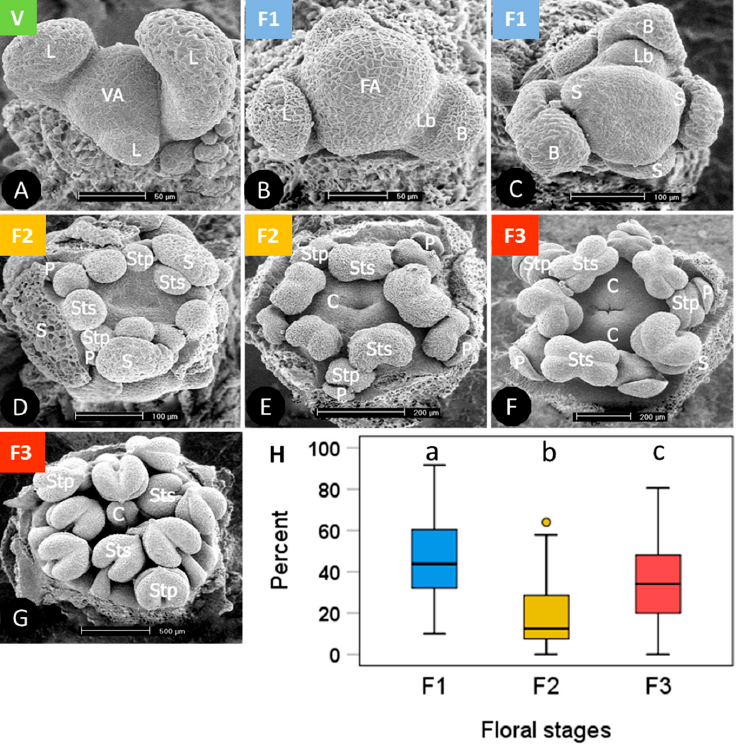
Figure 1. Saxifraga moschata Wulfen. Developmental stages of floral buds in winter dormant individuals at the time of the freezing experiments: green: vegetative (V); blue: early floral stages (F1); yellow: floral middle stages (F2); red: floral late stages (F3). ( A ) vegetative apex (VA) with leaf primordia (L) in alternate position; ( B ) floral apex (FA) shortly after the transition from vegetative to floral and lateral bud (Lb) with bract ( B ); ( C ) the apical dome has further flattened and sepal primordia (S) have emerged; ( D ) sepal, and petal (P) primordia and two whorls of stamens in episepal (Sts) and epipetal (Stp) position have formed; ( E ) Carpel (C) margins appear as a crater-like structure. Stamen primordia have started to differentiate into filaments and anthers. Sepals that had begun to conceal the flower within had been removed; ( F ) elongating carpels have formed a cone, pollen sacs are clearly distinguishable; ( G ) carpel tips (c) have bent outside to form stigma lobes. Inside the carpels ovule primordia have emerged along the placental ridge (not visible in the picture); sepals and petals were removed. ( H ) percentage range of floral buds in different stages per individual; boxes show the median (line inside box), the 25th and 75th percentile (top and bottom of box), maximum and minimum values within the 1.5 times the interquartile range (whiskers), and outliers (circle); different lowercase letters indicate statistical differences among floral stages ( n = 53 individuals, F1 > F3 > F2, p ≤ 0.007, one-way ANOVA). Photos with permission of I.